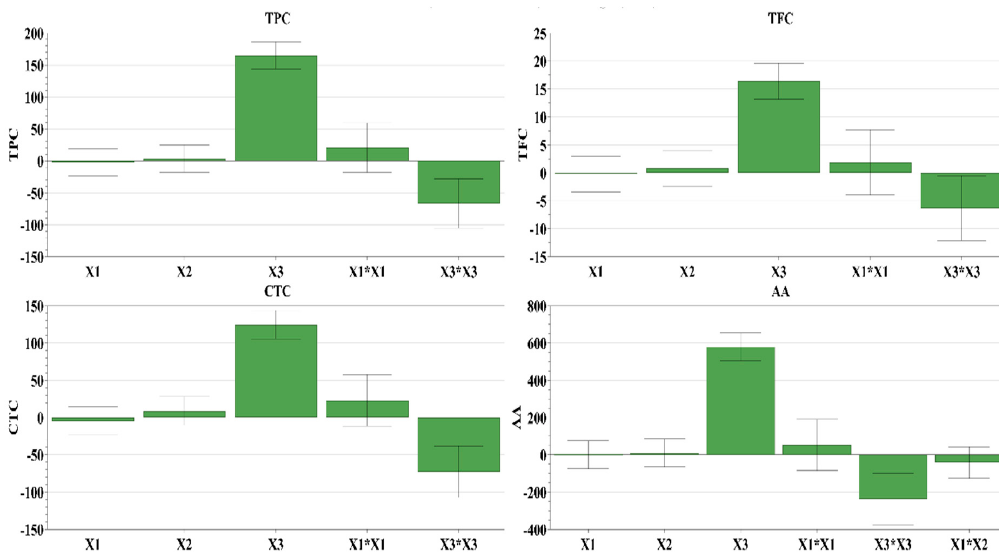
Figure 1. Influence of working conditions on total phenolic content ( TPC ), total flavonoid content ( TFC ), condensed tannin content ( CTC ), and antioxidant activity ( AA ) by TEAC assay of hazelnut involucre extracts, presented as scaled and centered coefficient plots. X 1 , stirring time (min); X 2 , pH; X 3 , water in solvent (% v/v ).